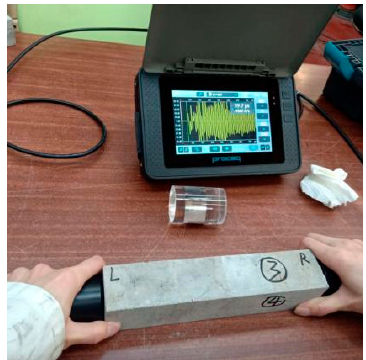
Figure 7. Proceq Pundit 200 ultrasound pulse velocity instrument.